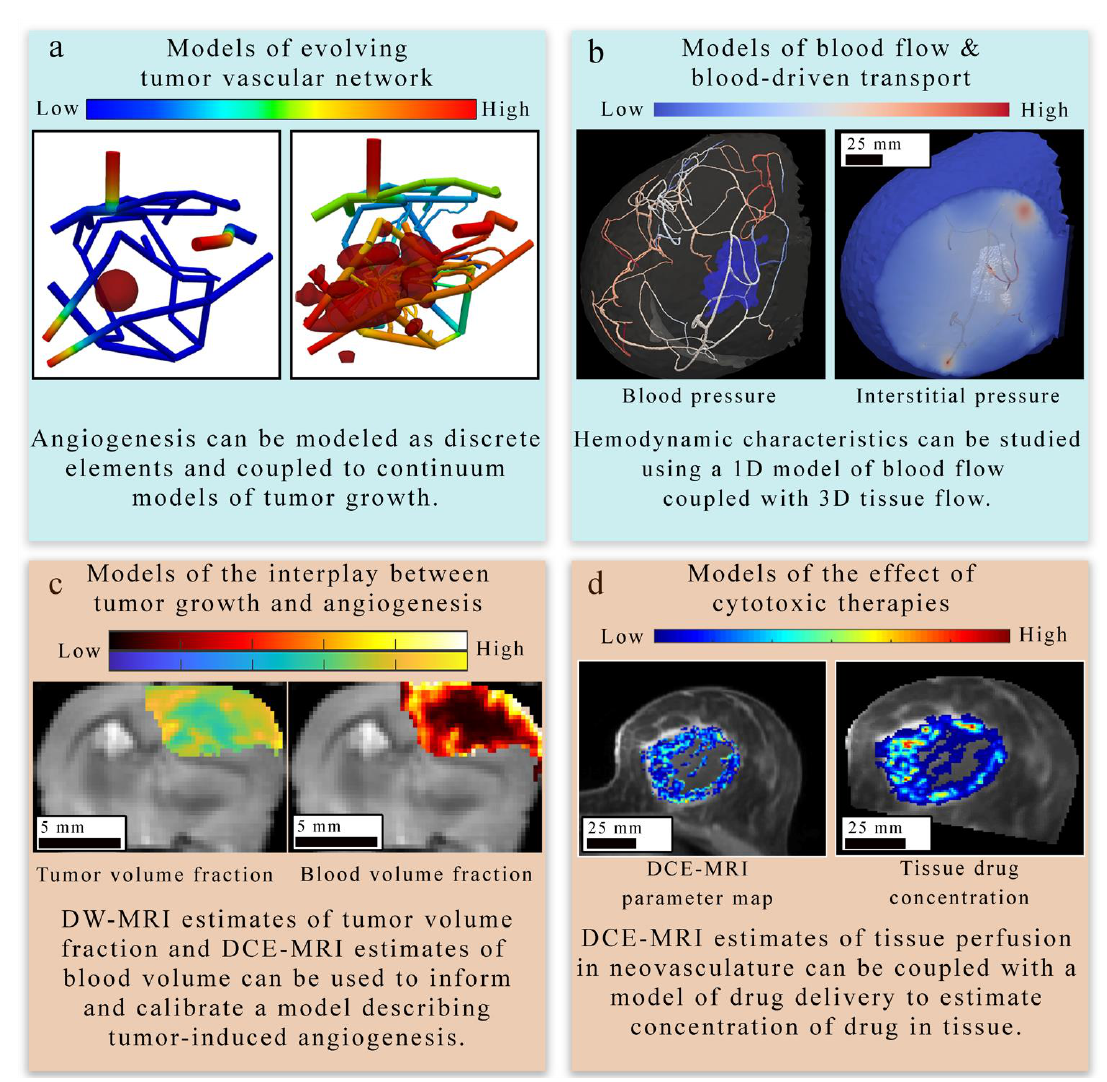
Figure 4. Overview of tissue-scale models of angiogenesis and vasculature. There are four main approaches to modeling tumor-induced angiogenesis and vasculature at the tissue scale level. (Panel a ) provides an example of a discrete modeling approach [122,123] used to describe the evolving geometry of tumor vasculature in response to tumor growth. This simulation employs a 3D continuous multi-species tumor growth model coupled to a 1D discrete model of angiogenesis. The tissue domain initially features a small spherical tumor core, which grows in response to the changing vasculature network. The colors in the network show the nutrient volume fraction. (Panel b ) displays how the function of existing tumor vasculature in the breast can be studied with computational fluid dynamics [33] to estimate hemodynamic properties of the vascular network. In (panel c ), diffusion weighted (DW-) and DCE-MRI acquired in a murine brain tumor model (C6 glioma) are used to provide tumor volume fraction and blood volume fraction estimates to initialize and calibrate a model of tumor-induced angiogenesis. The model derived estimates of tumor and blood volume fraction are overlaid on an axial T 2 -weighted MRI through the center slice of the tumor. A coupled set of PDEs [32] are used to describe the proliferation, diffusion and death of tumor cells and the angiogenesis, diffusion, and regression of the vasculature. In (panel d ), estimates of tissue perfusion in the breast derived from quantitative imaging are coupled with a mathematical model of drug delivery [86] and tumor growth to observe the effect of tumor vasculature on drug distribution and tumor response to treatment. Both the left and right images in (panel d ) show quantitative maps of DCE-MRI parameters or drug concentration overlaid on an anatomical image acquired in the same plane. The right drug concentration map is an enlargement of the computational domain.